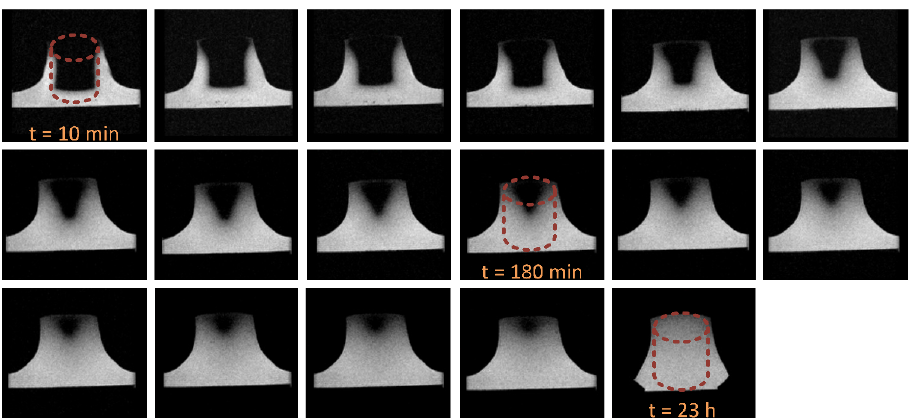
Figure 5. T2-weighted visualization of the water diffusion front in poly(VEImBr) (21.5 ± 2 °C; TR: 2500.0; TE: 35.0; MBAA: 2 mol%).